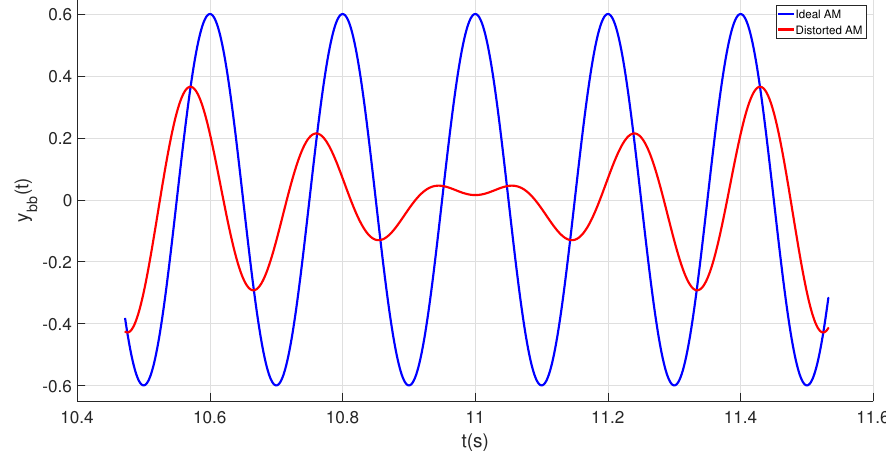
Figure 2. Baseband signal of AM modulation.